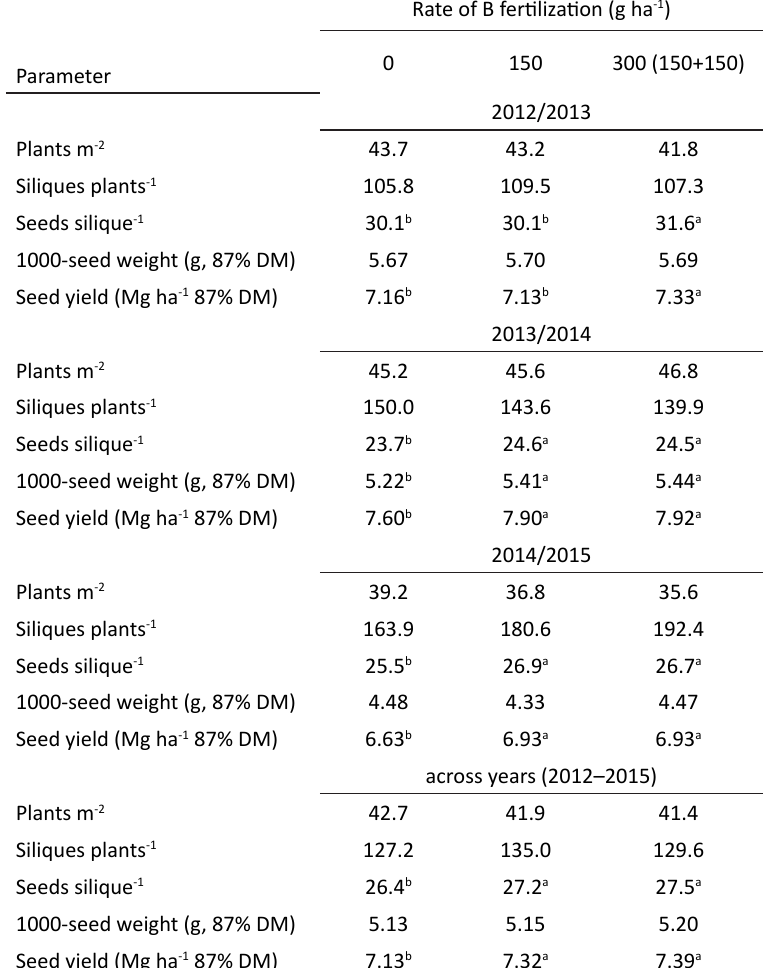
Table 5. Influence of foliar application of B on the yield components and seed yield